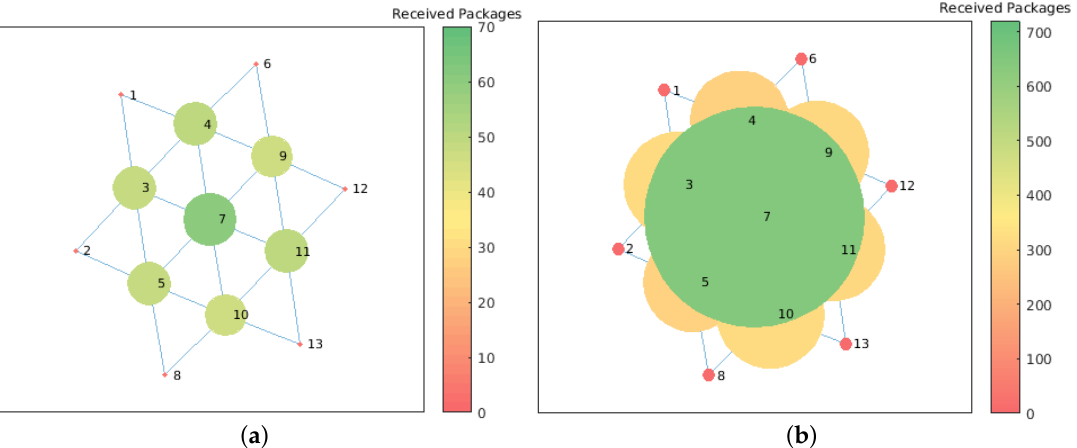
Figure 23. Communication cost in terms of number of received messages by each node. Communication of data for cross-correlation after 1 h of execution: ( a ) distributed approach—number of messages between 0 and 70; and ( b ) centralized approach—number of messages between 0 and